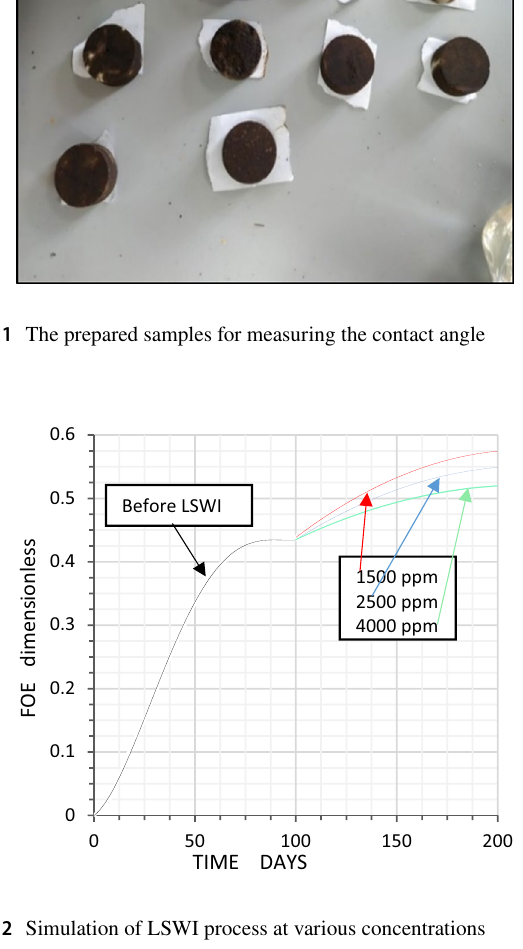
Fig. 2 Simulation of LSWI process at various